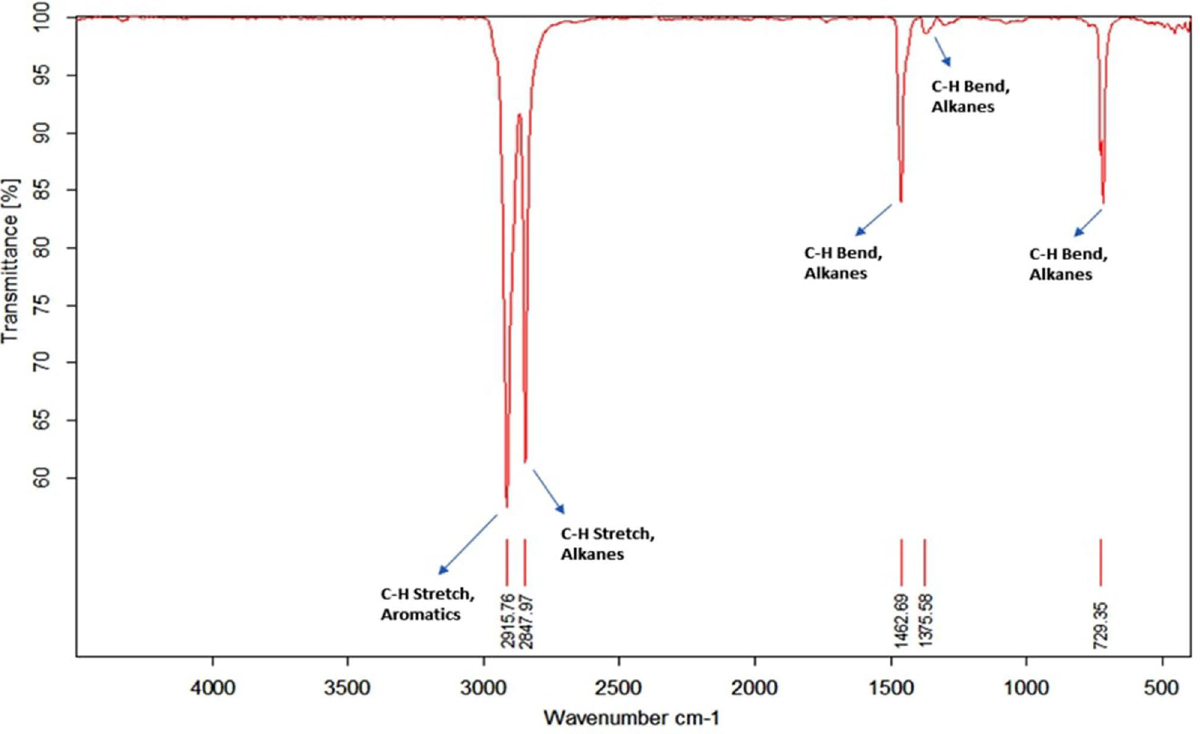
Figure 15. FT-IR spectrometry results of control LDPE sheet.